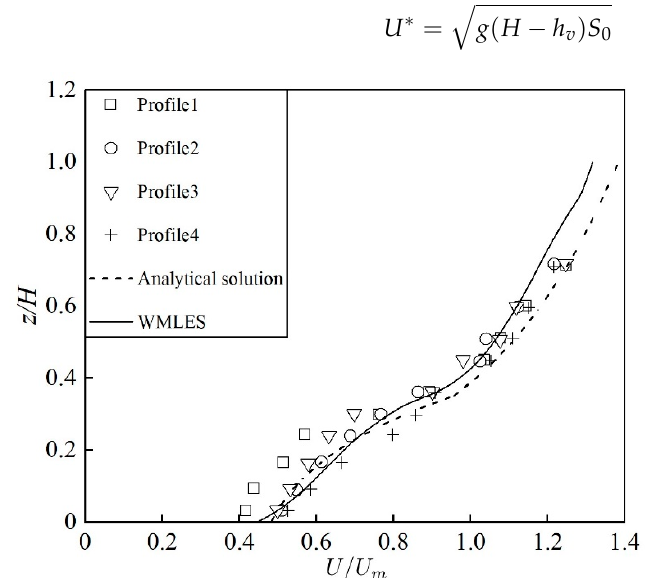
Figure 3. Comparison of the time-averaged dimensionless streamwise flow velocity.